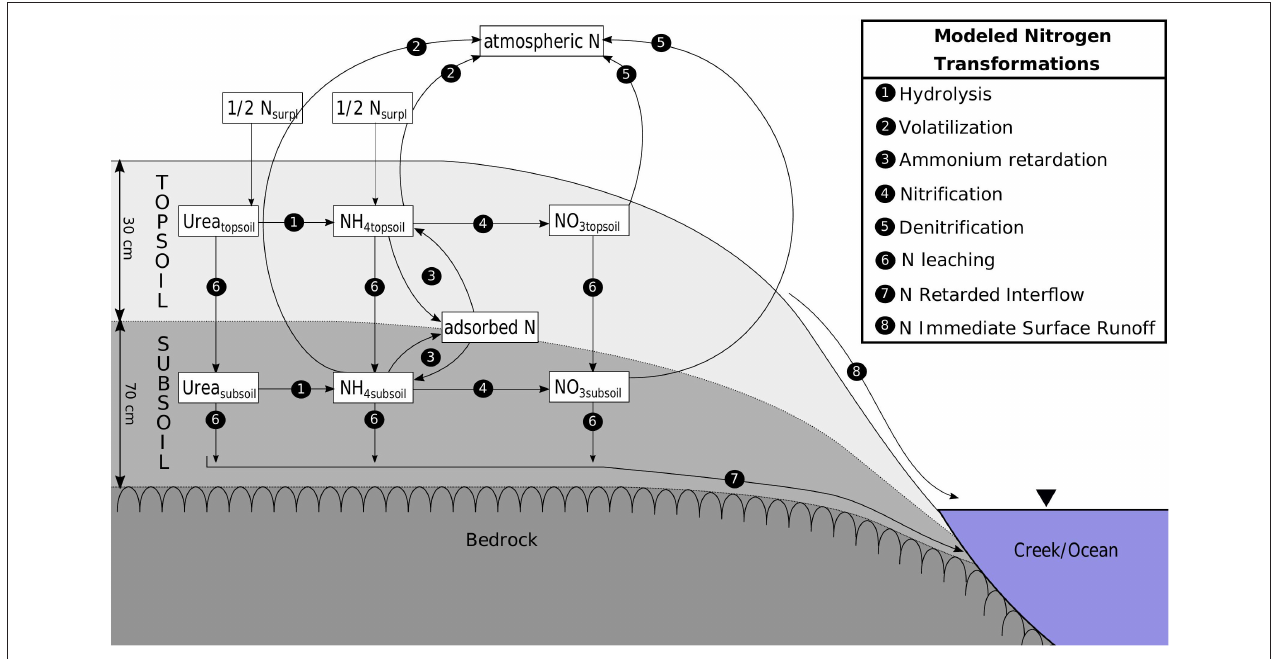
FIGURE 2 | Transformations (processes 1–5) and transport (processes 6–8) of urea, ammonium, and nitrate modeled for top and